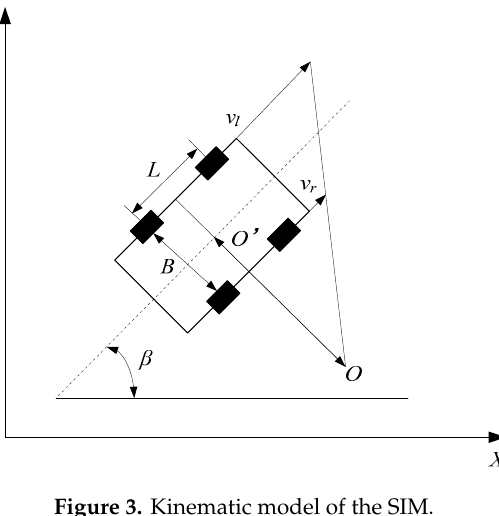
Table 1. Main performance parameters of the self-developed SIM.